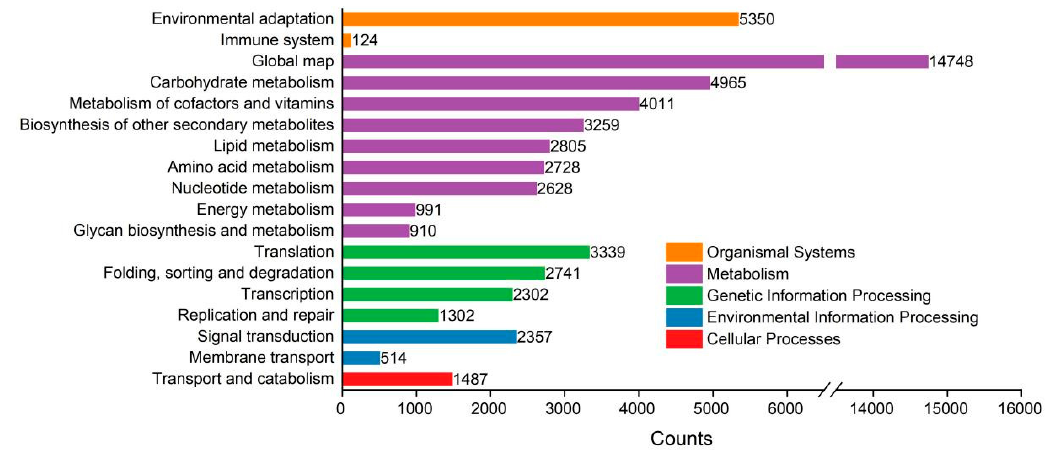
Figure 5. Histogram of the KEGG Pathway classification of P. massoniana and the Z pine unigenes.